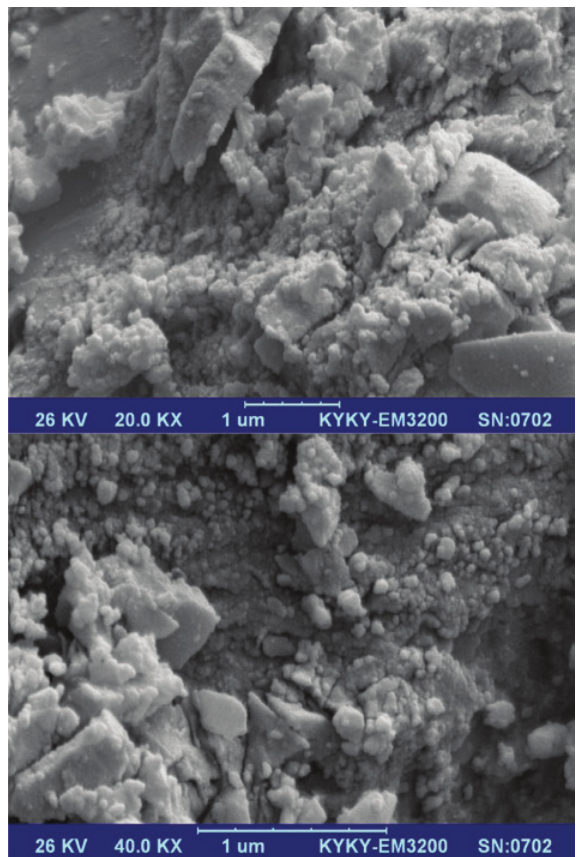
O nanoparticles 12 19